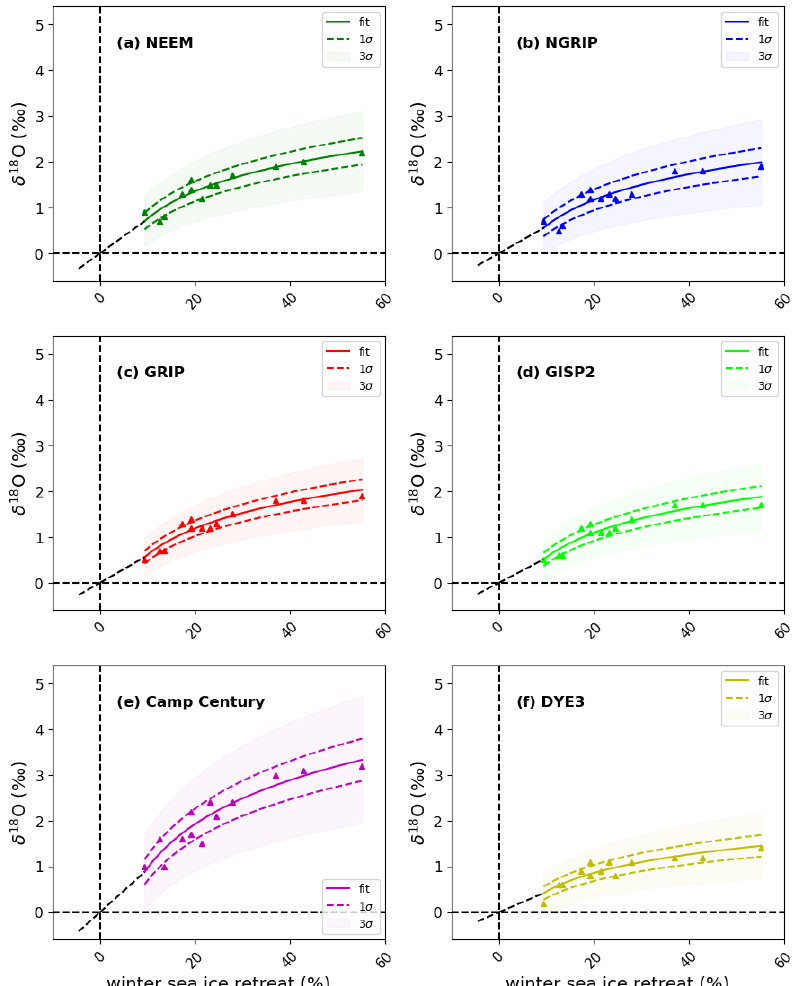
Figure A6. Simulated δ 18 O p anomalies as a function of winter (March) sea ice retreat. The retreat of sea ice is calculated as the percentage change in winter sea ice extent compared to the 125ka control simulation. Ice core sites shown: (a) NEEM, (b) NGRIP, (c) GRIP, (d) GISP2, (e) Camp Century and (f) DYE3. Triangles represent results from the sea ice sensitivity experiments performed by Malmierca-Vallet et al. (2018). Solid lines signify best fit lines (fit = b × (log( x ) − a )). Also shown are ± 1SD (lines with dashes) and ± 3SD uncertainties (shade envelopes) on the best fit curve. We assume a straight line regression (fit = a + bx ) for winter sea ice losses between 0% and 9% and increases up to − 4.5%. This figure is an adaptation of Fig. 10 shown in Malmierca-Vallet et al.